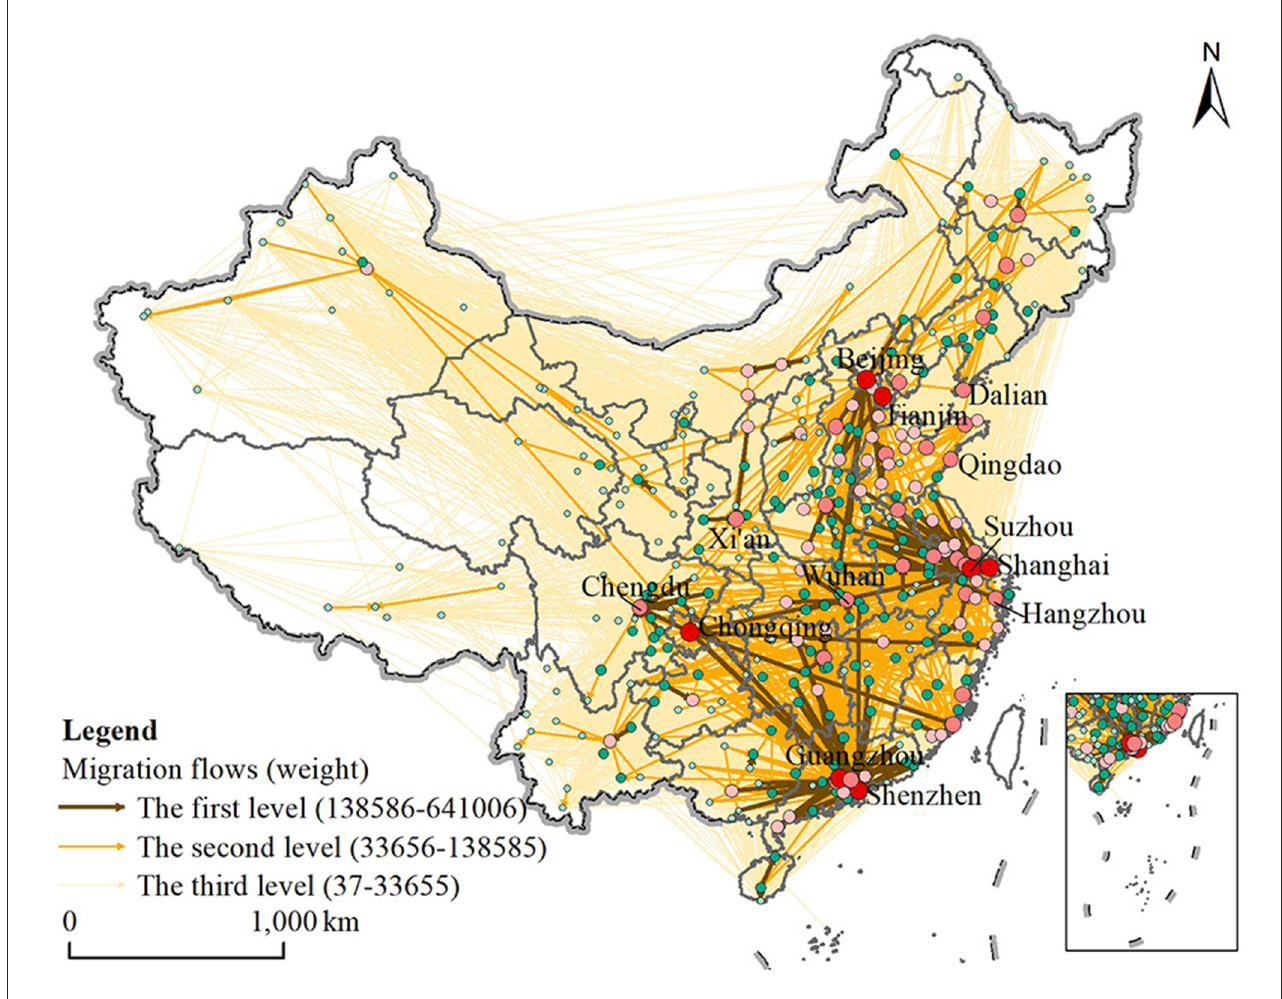
FIGURE2 The spatial pattern of intercity migration flows at different levels in China.